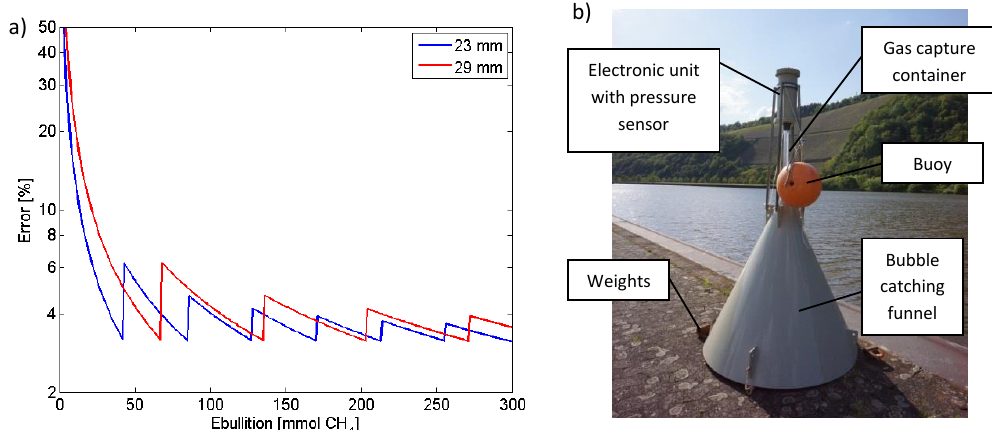
Figure 2. (a) Error in the volume determination in relation to the captured gas for two different diameters of the gas capture container (23 and 29mm). The saw-like steps in the curve result from venting of the system and the start of a new filling cycle. Since for every cycle two additional differential pressure sensor readings are necessary, error increases temporarily due to flushing. (b) Automated bubble trap device. The instrument operates submerged and catches rising bubbles. The captured gas is stored in the cylindrical gas capture container and the fill height of the container is measured via differential pressure with the electronic unit.